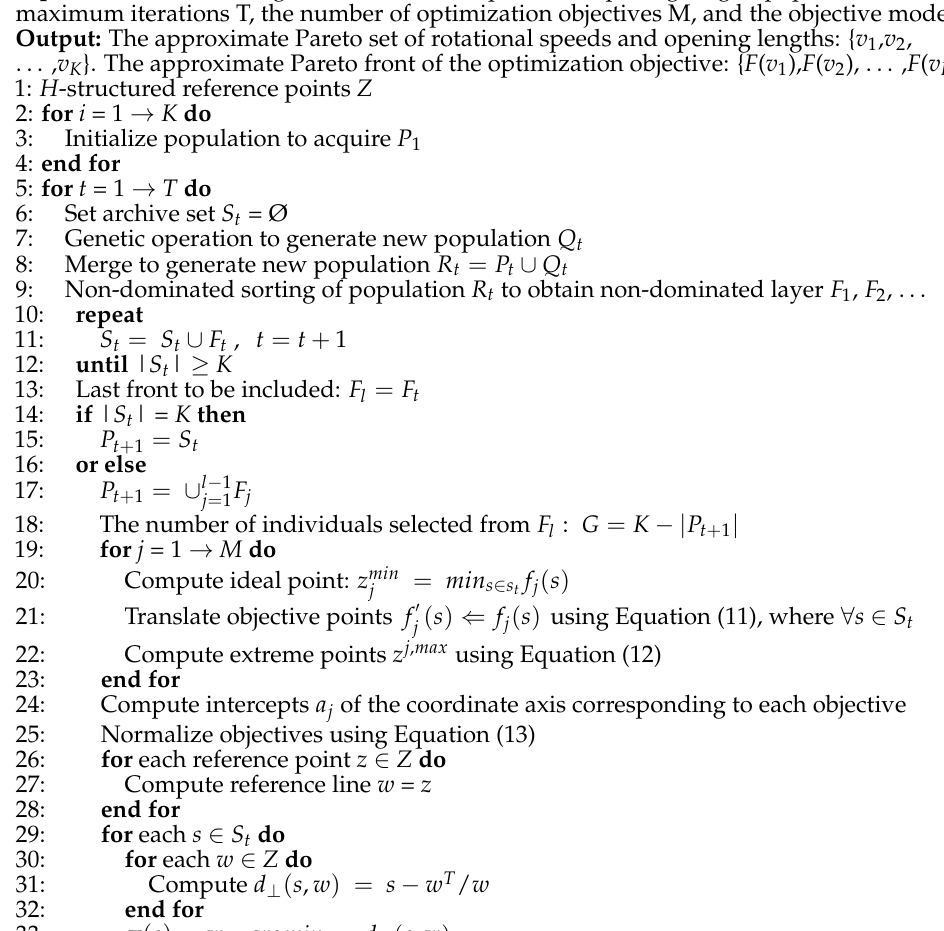
Algorithm 1 Optimization of the fertilization decision based on